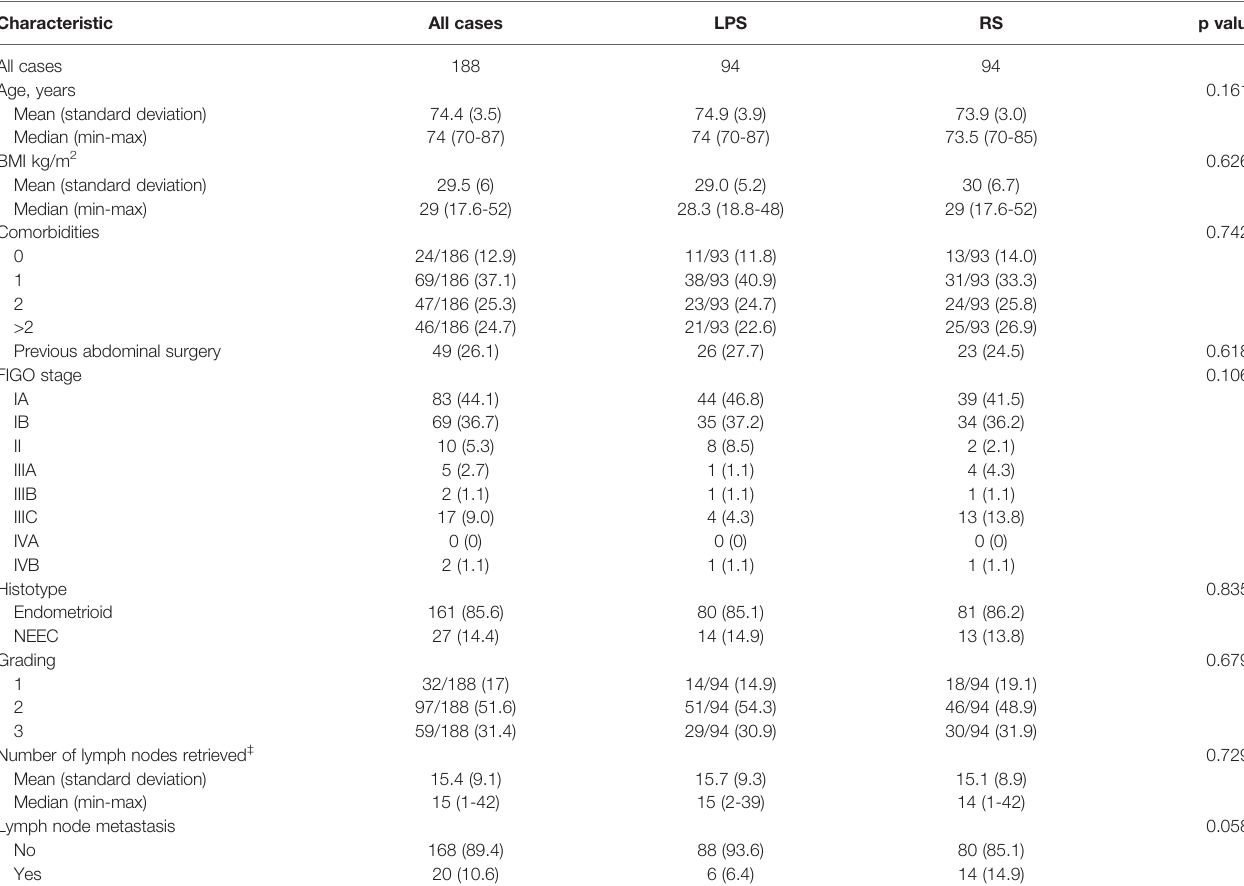
TABLE 3 | Clinical and pathological characteristics of 188 matched patients with endometrial cancer according to the type of surgery.